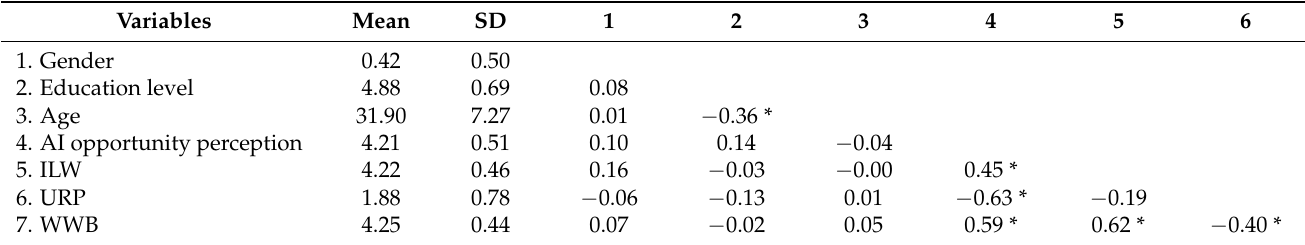
Table 3. Means, standard deviations, and correlations.